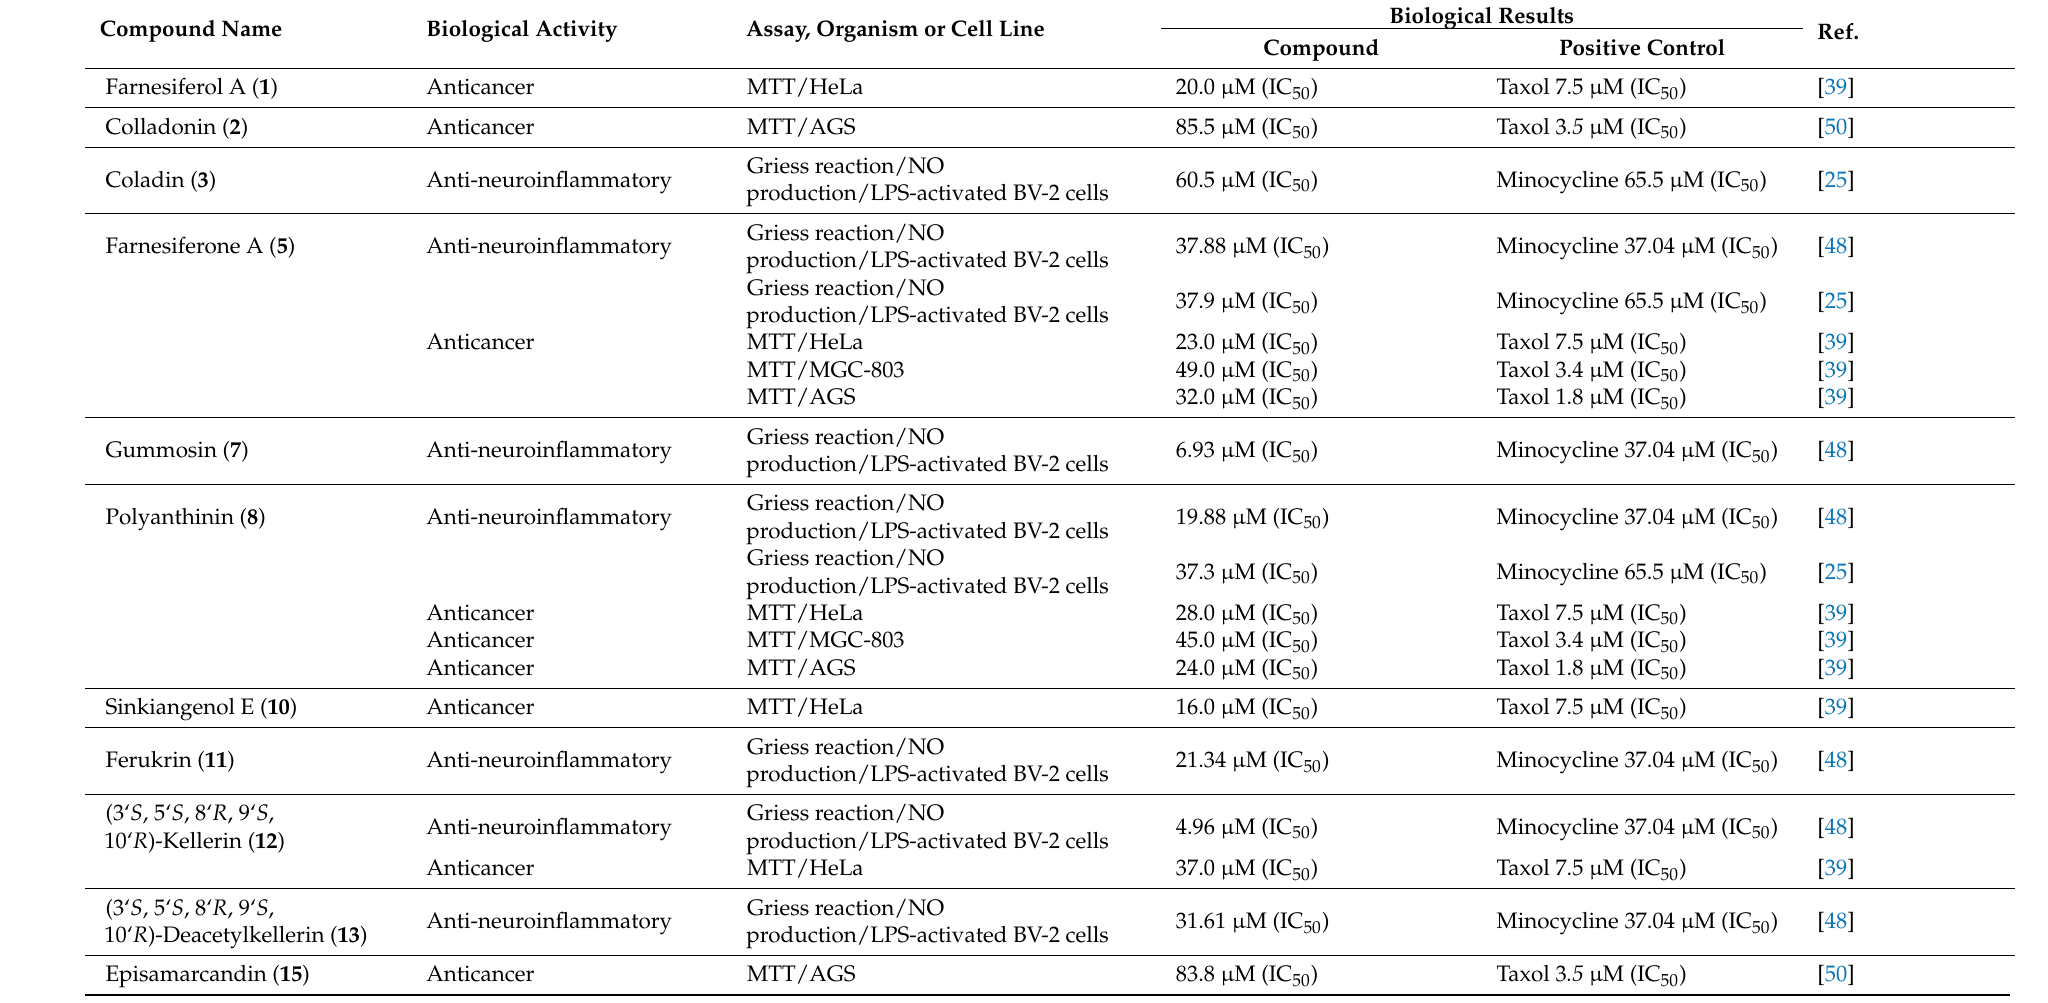
Table 1. Biological activity of reported metabolites from Ferula